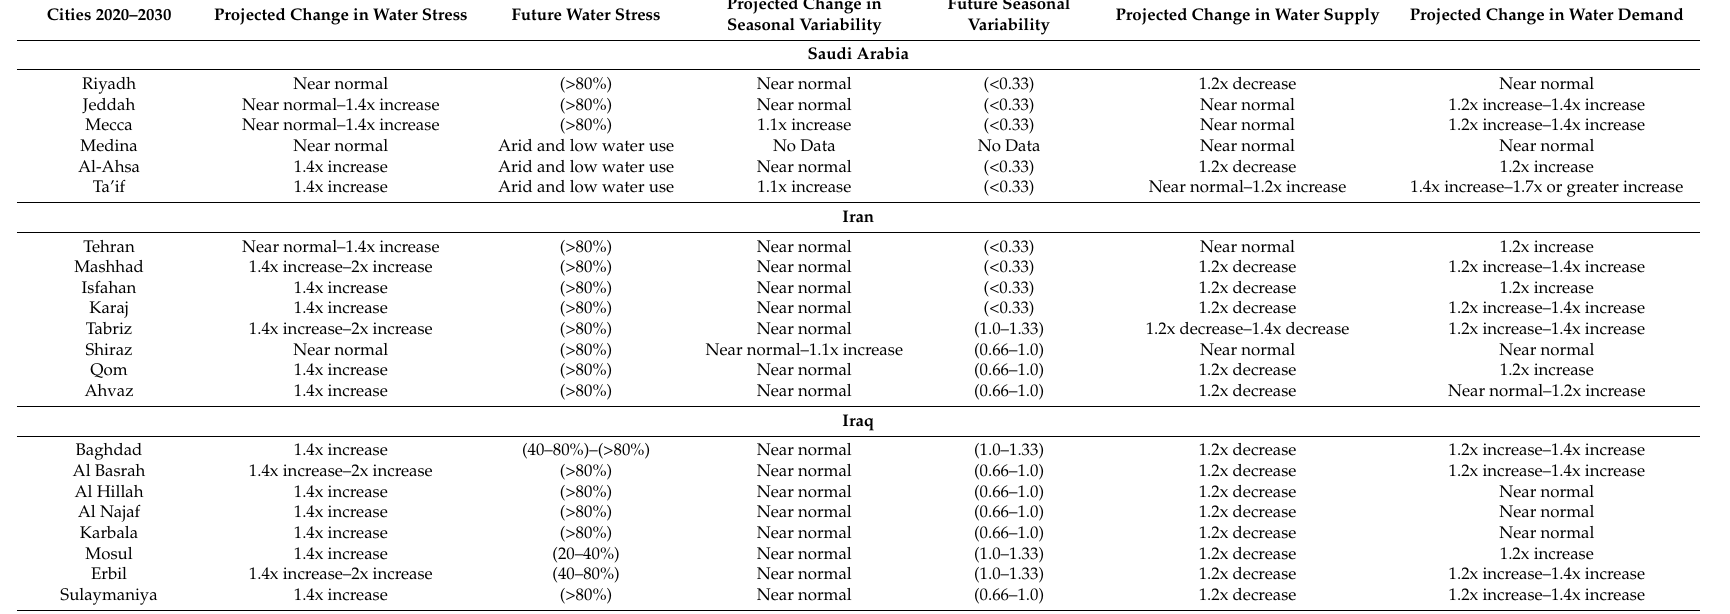
Table 2. Projection of Water Risk for selected Middle Eastern cities with populations greater than one